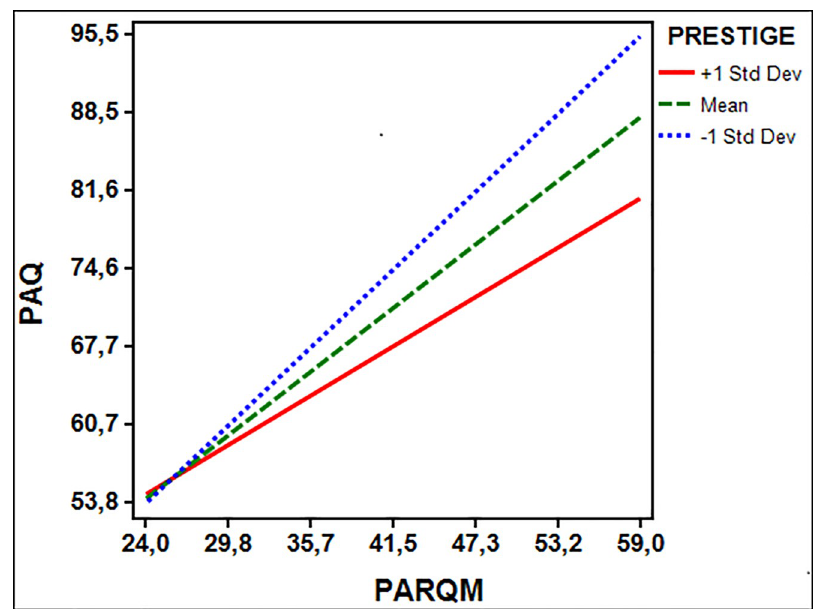
Fig 1. Maternal acceptance-rejection predicting psychological maladjustment at varying levels of prestige in the late childhood (9–10 years old). PAQ = psychological maladjustment (higher scores are indicating maladjustment); PARQM (higher scores are indicating maternal